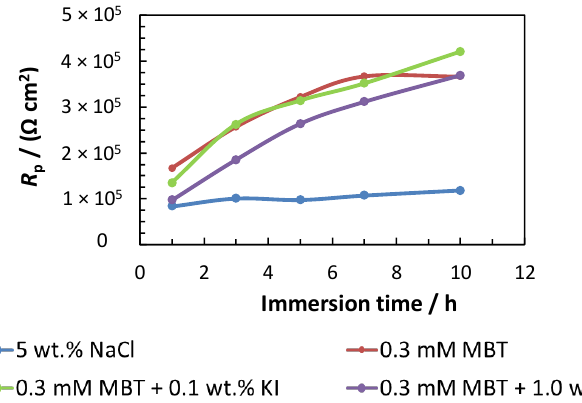
Figure 6. The variation of R p values with increasing immersion time for the AA6082 aluminium alloy samples immersed for 1–10 h at 25 °C in 5 wt.% NaCl solution with or without 0.3 mM MBT or 0.3 mM MBT and the addition of either 0.1 or 1.0 wt.% KI.